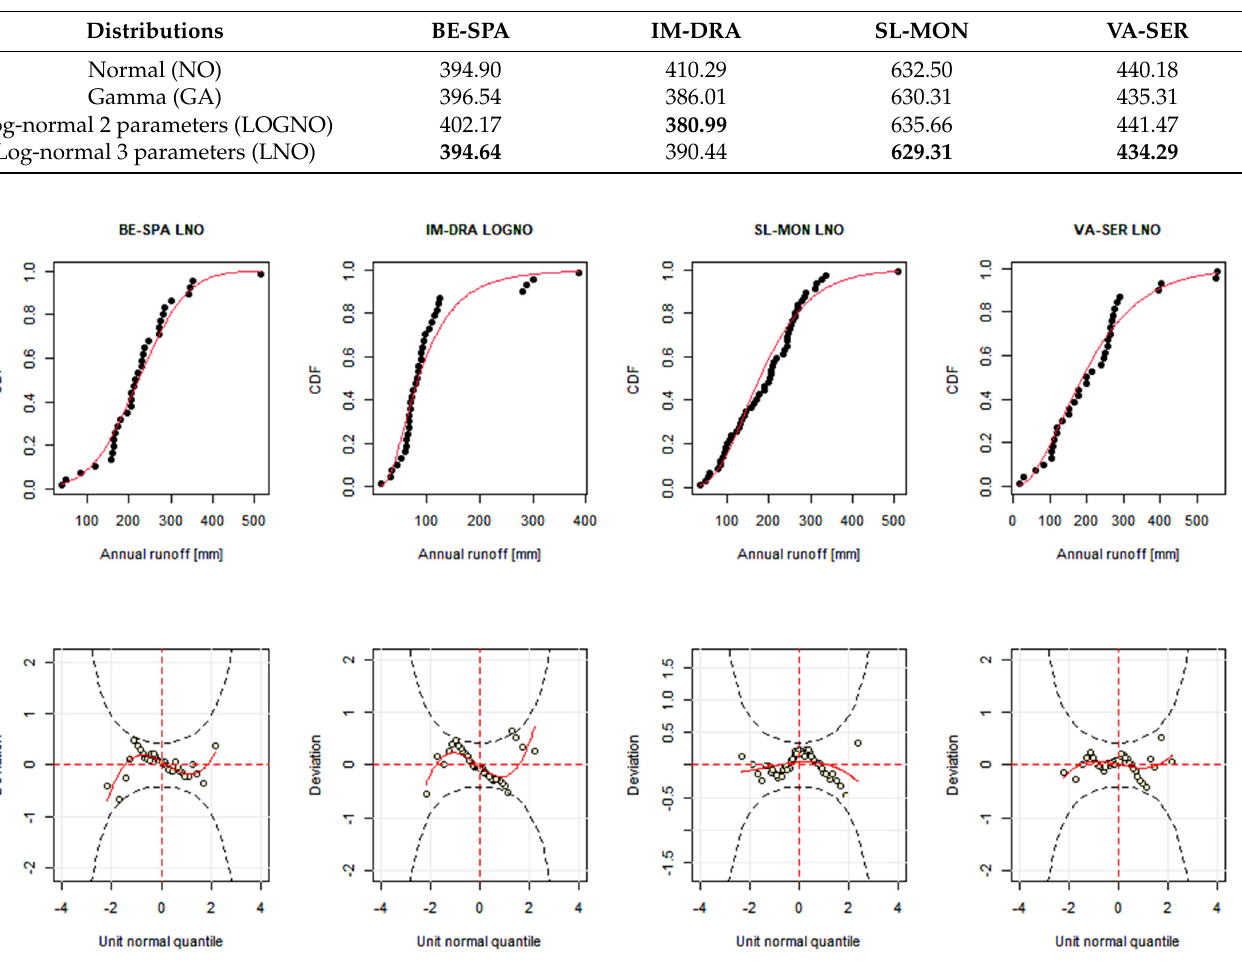
Figure 4. Empirical and theoretical cumulative distribution functions (cdfs) and worm plots for the distributions with the lowest AIC values for all the stations. Table 2. AIC values for all the considered distributions of the stationary analysis. In bold are shown the lowest AIC values among the analyzed distributions for each